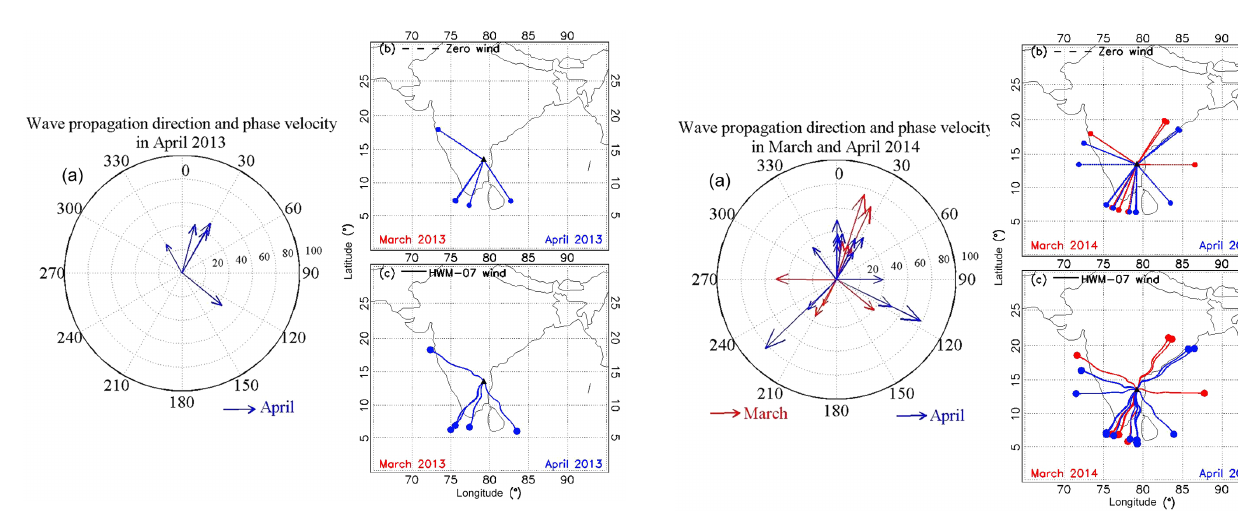
Figure 11. As in Fig. 5 but for the year